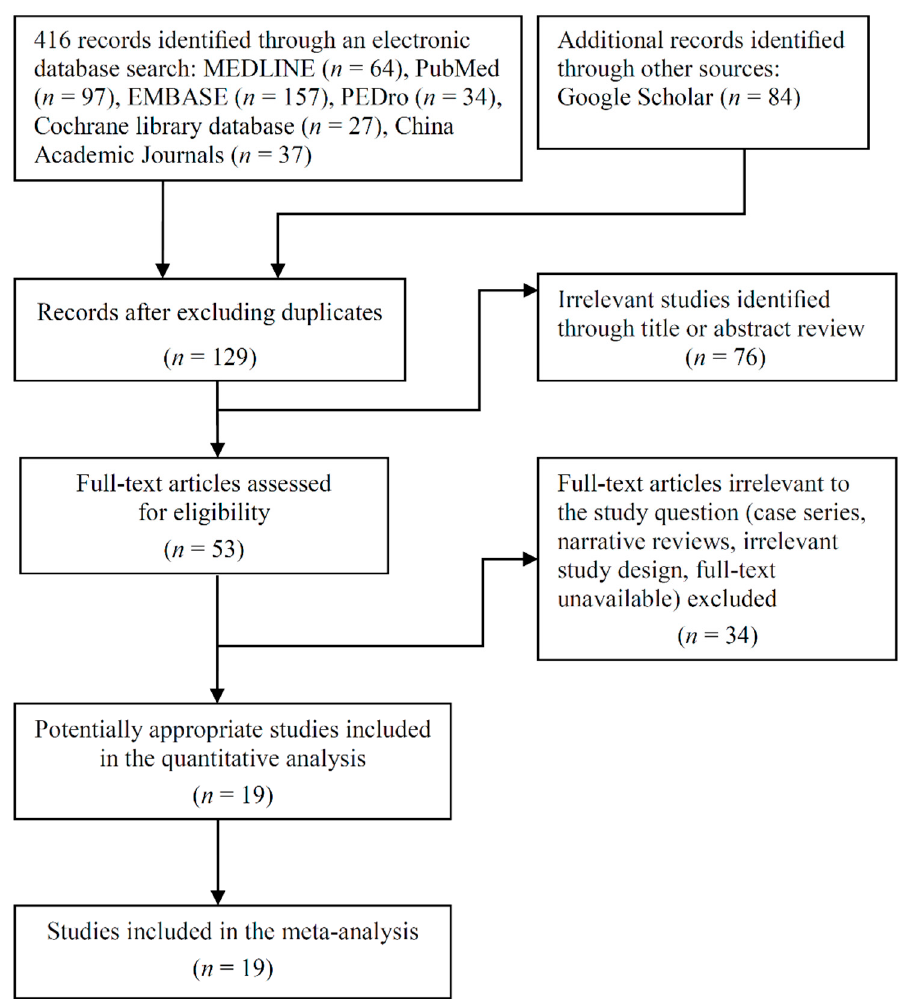
Figure 1. Flow chart of enrolled studies.